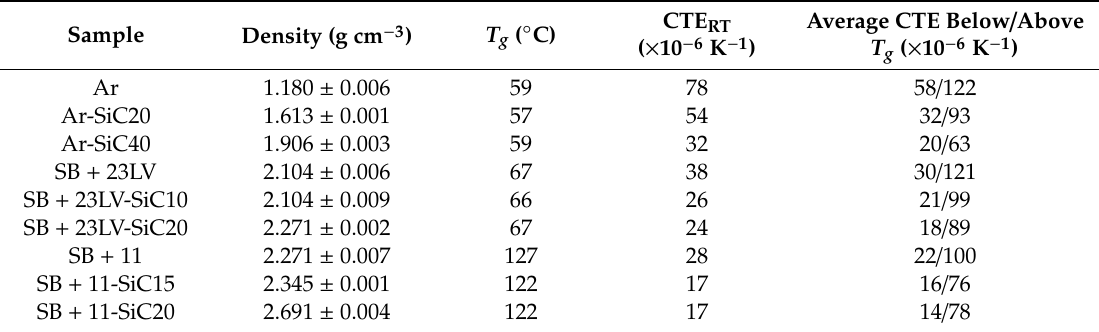
Table 3. Densities, T g , and CTEs of investigated samples at RT and their average values in two temperature ranges below and above T g